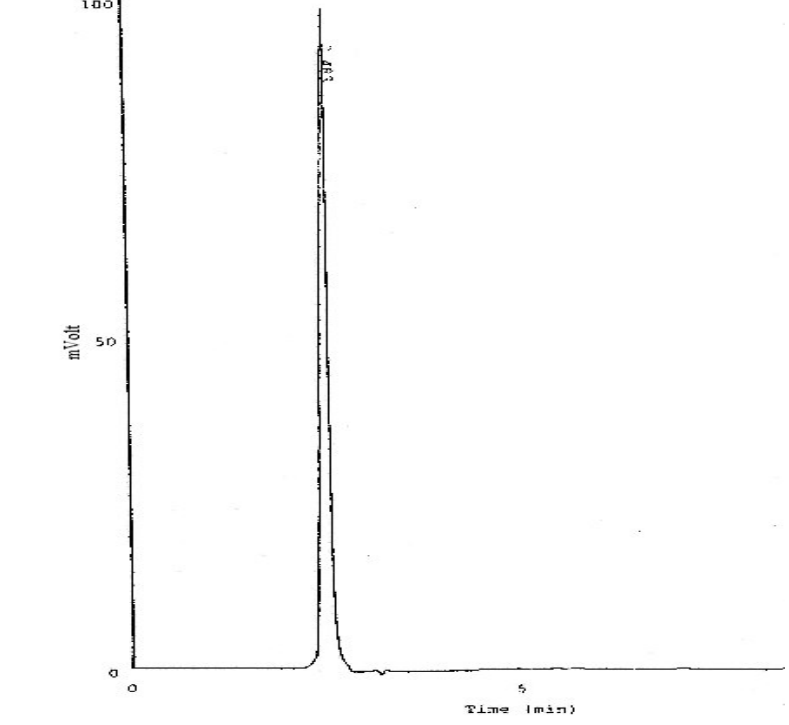
Figure 2. HPLC Chromatogram and data peak report of ampicillin 250 mg capsules manufactured by Kosar Pharmaceutical Co. of